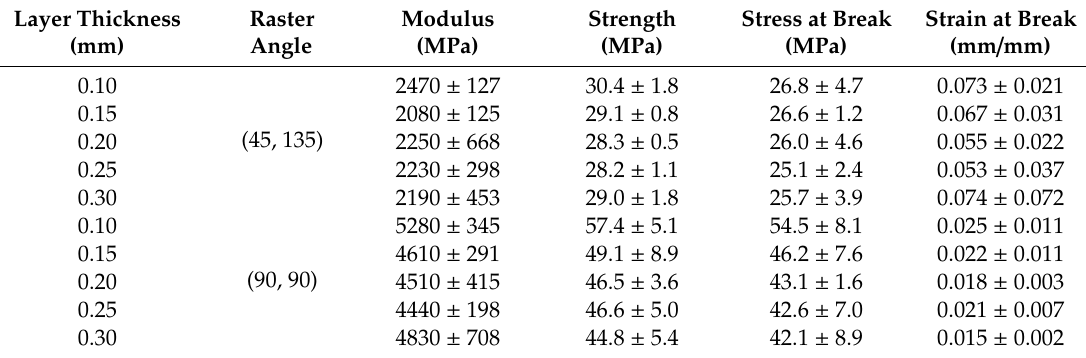
Table 2. Results of the mechanical tests of the 3D printed